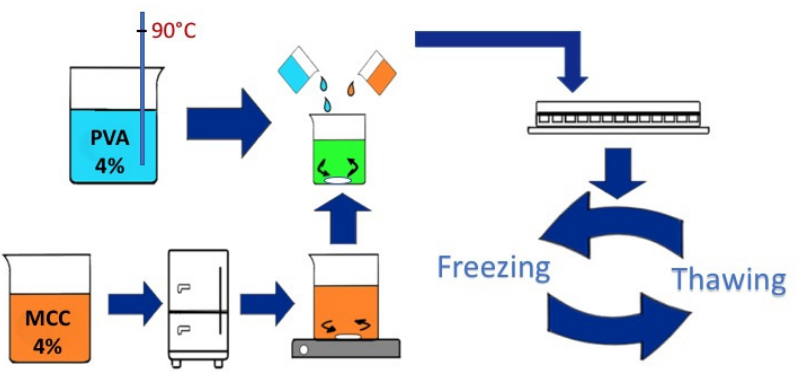
Figure 1. Preparation scheme of PVA/MCC hydrogels.